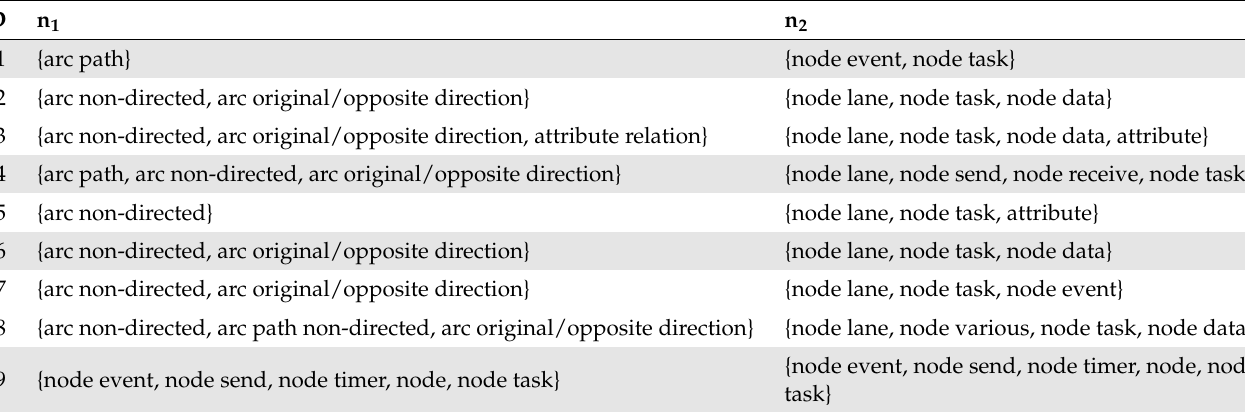
Table A7. Definitions on DMQL .